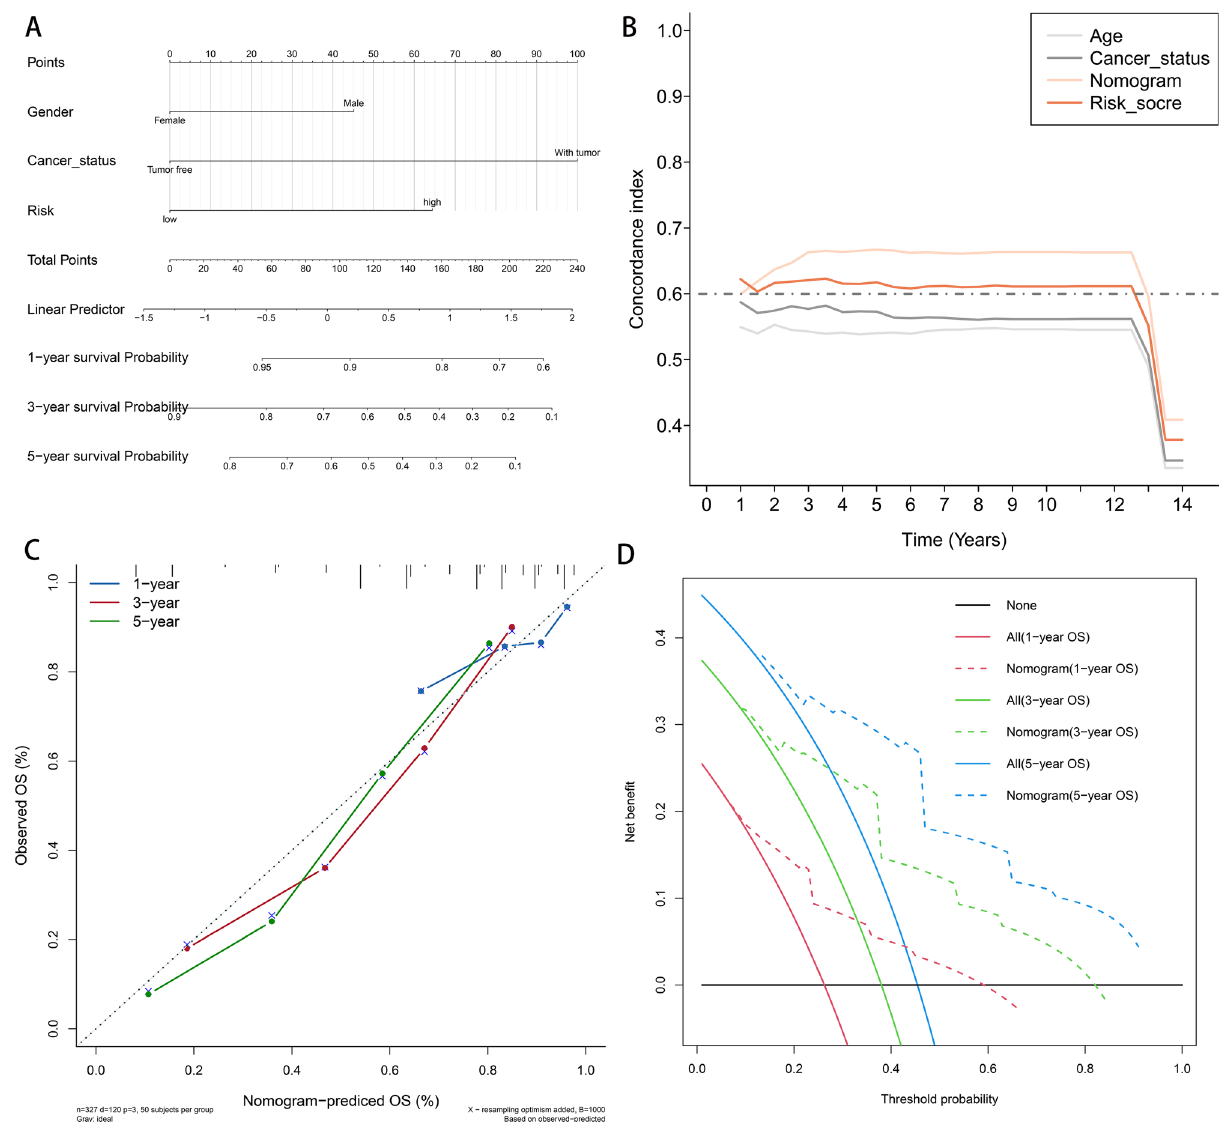
Figure 10. The nomogram model for the prediction of prognosis for the TCGA whole set. ( A ) Nomogram contained gender, cancer status and risk to predict survival. ( B ) Concordance index graph of nomogram in different years. ( C ) Calibration curve for nomogram in 1-, 3-, 5-year OS. ( D ) Decision curve analysis for nomogram in 1-, 3-, 5-year OS. TCGA The Cancer Genome Atlas, OS overall